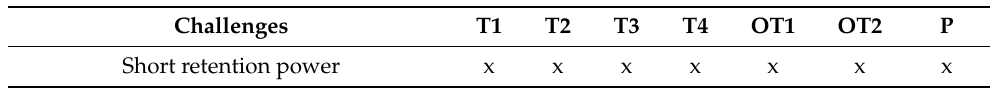
Table 7. Short retention